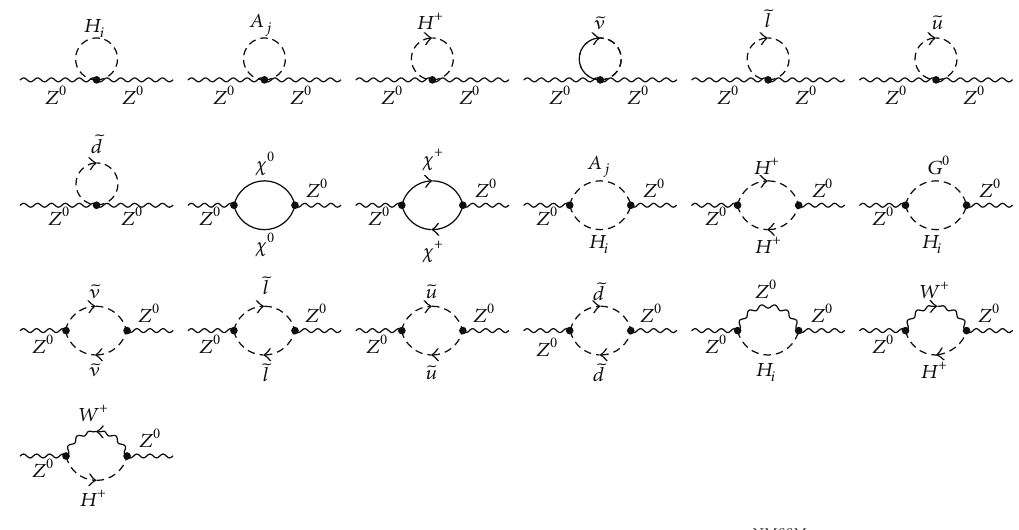
Figure 5: Feynman diagram contribution to the self-energy Π NMSSM 𝑍𝑍 (𝑠)